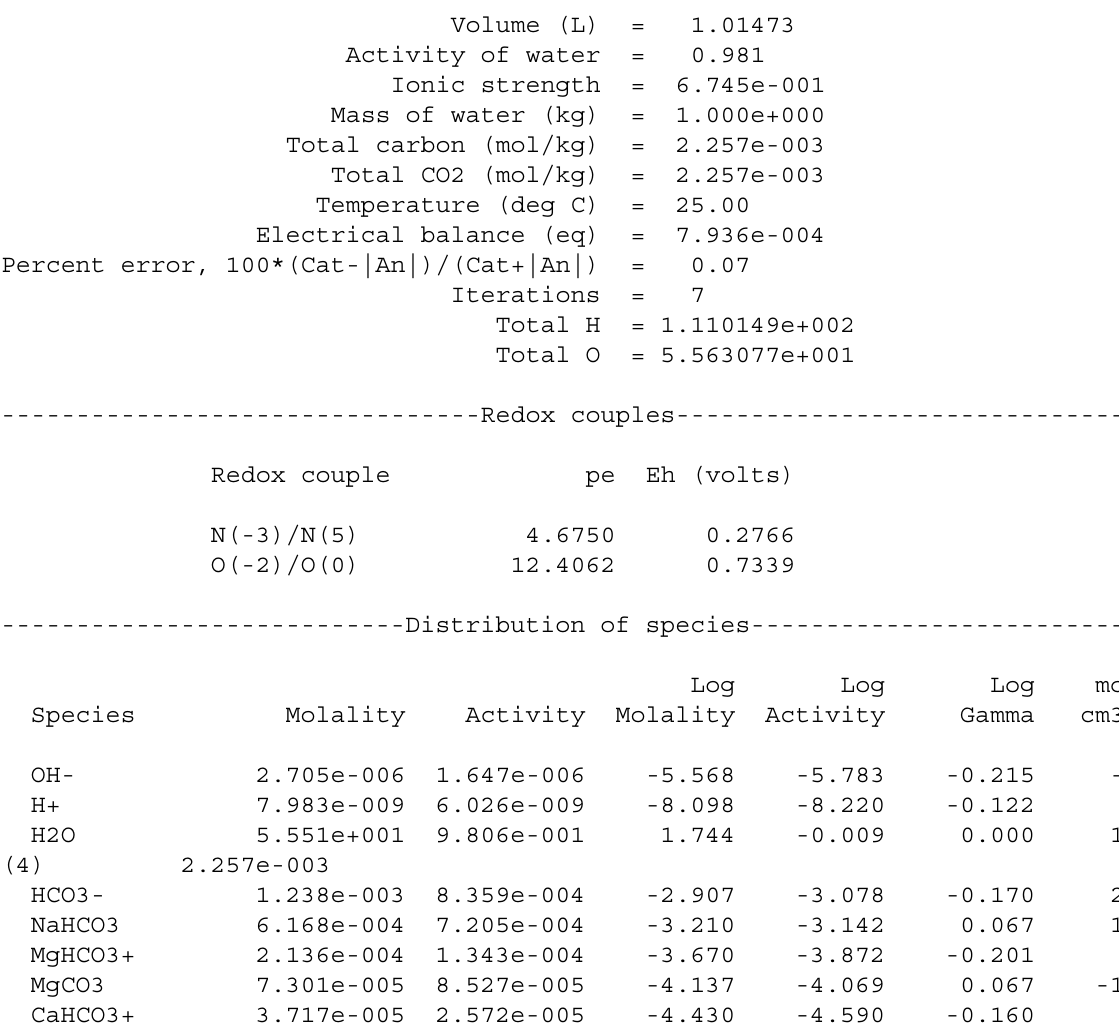
Table 11. Output for example